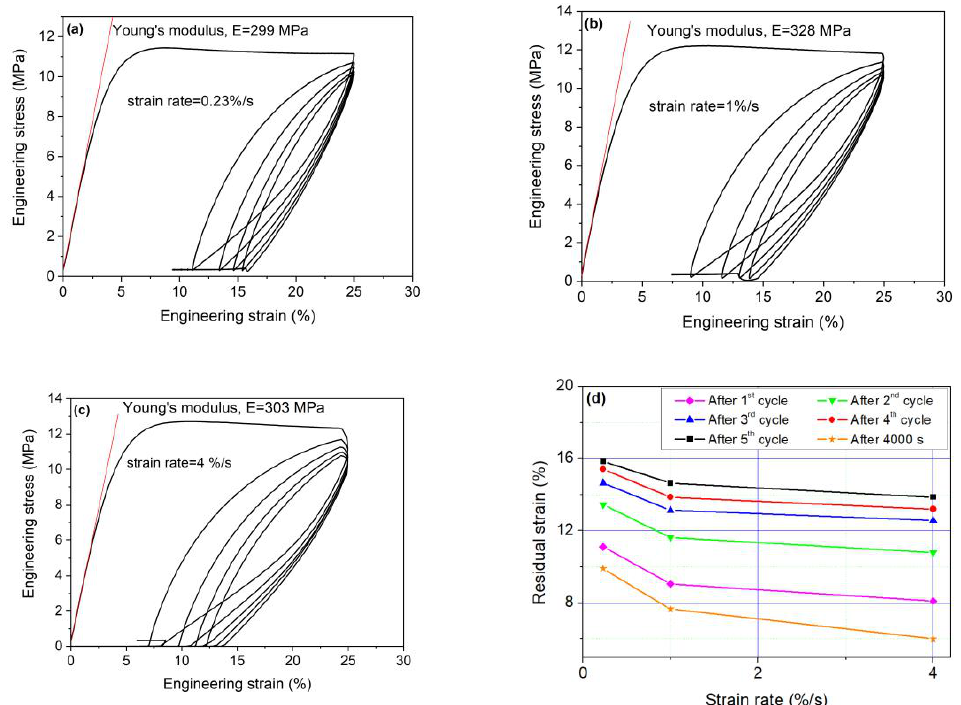
Figure 5. Relationship between the engineering stress and strain for strain rate of ( a ) 0.23%/s, ( b ) 1%/s and ( c ) 4%/s. The linear slope of the linear part (red color line) stands for the Young ’ s modulus and ( d ) residual strain summary for various strain rates.